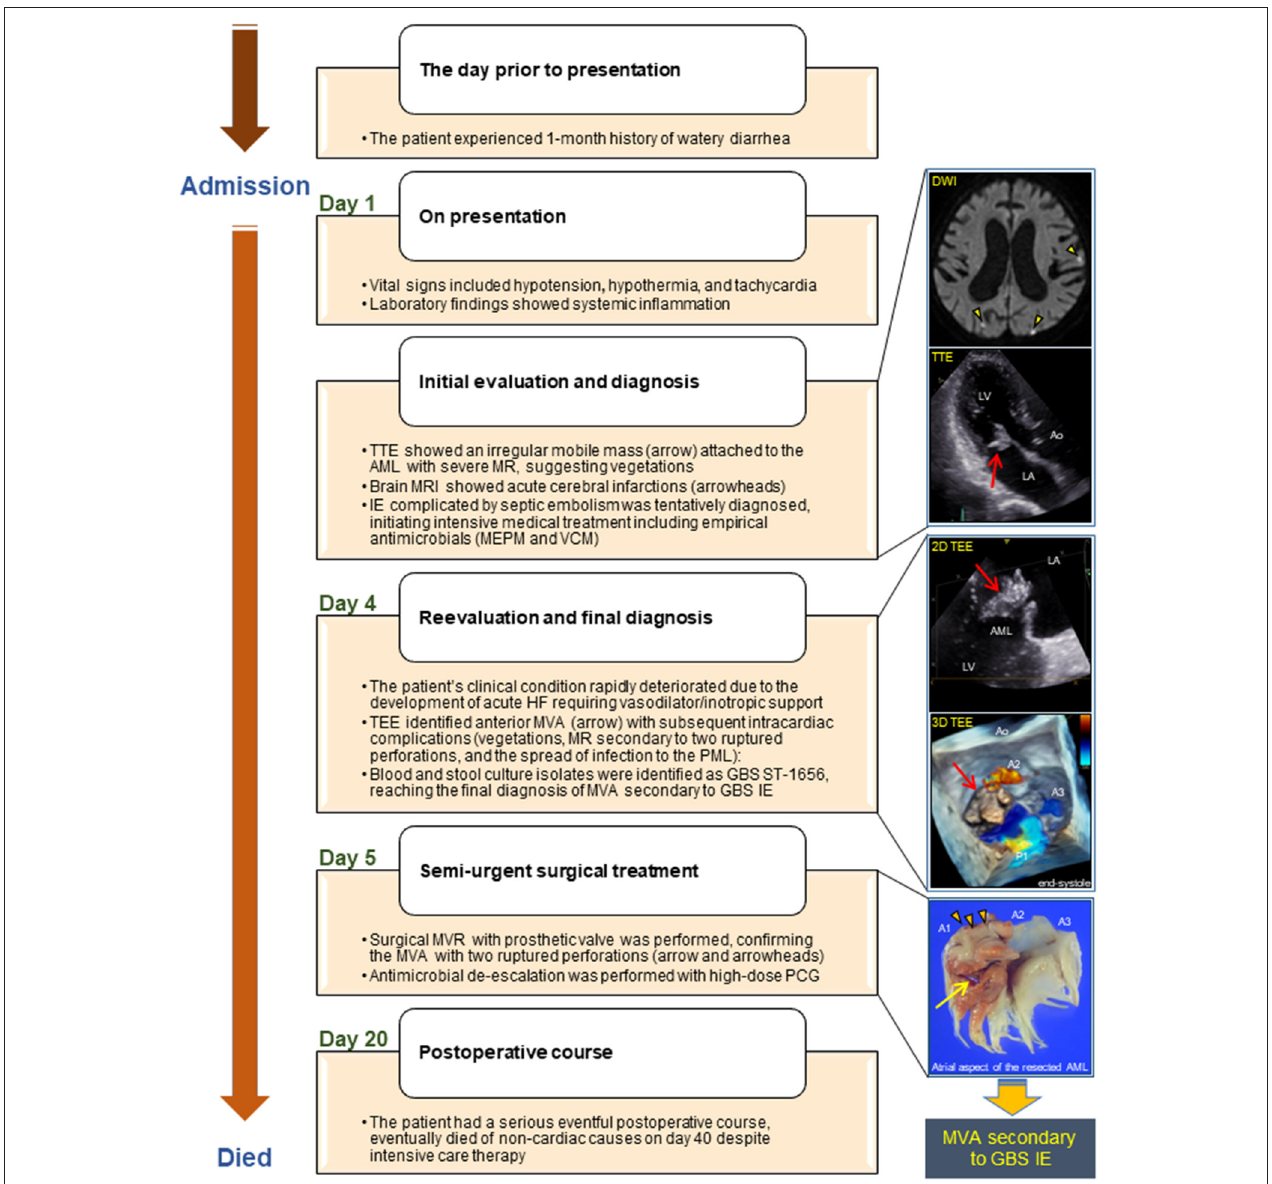
FIGURE 4 | Illustrated timeline of the case. AML, anterior mitral leaflet; Ao, aorta; DWI, diffusion-weighted image; GBS, Streptococcus agalactiae ; HF, heart failure; IE, infective endocarditis; LA, left atrium; LV, left ventricle; MRI, magnetic resonance imaging; MEPM, meropenem; MR, mitral regurgitation; MVA, mitral valve aneurysm; MVR, mitral valve replacement; PCG, penicillin G; PML, posterior mitral leaflet; ST, sequence type; TEE, transesophageal echocardiography; TTE, transthoracic echocardiography; VCM,